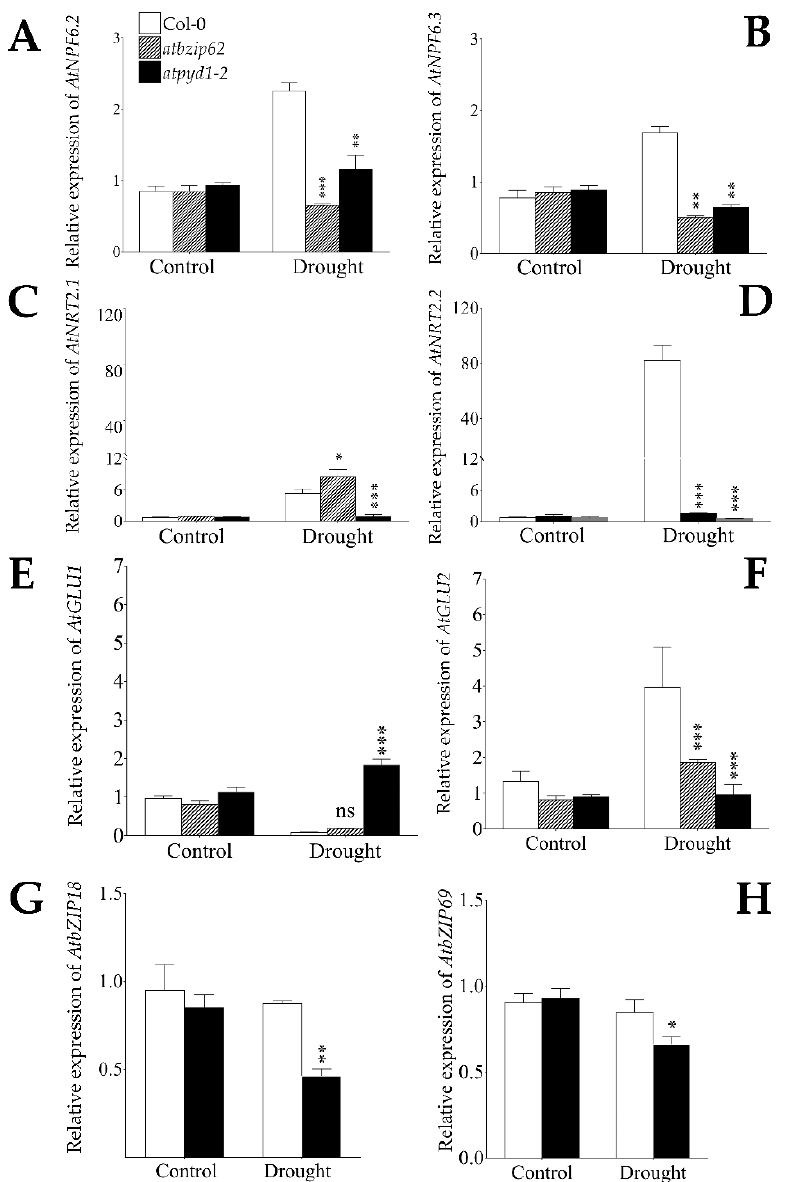
Figure 3. Transcript accumulation of low-, dual-, and high-affinity nitrate transporters and glutamate synthase-encoding genes in response to drought stress monitored in Arabidopsis Col-0, atbzip62 and atpyd1-2 mutant lines lacking AtbZIP62 and AtPYD1 , respectively, under drought stress. ( A ) Expression levels of AtNFP6.2 , ( B ) AtNPF6.3 , ( C ) AtNRT2.1 , ( D ) AtNRT2.2 , ( E ) AtGLU1 , ( F ) AtGLU2 , ( G ) AtbZIP18 , and ( H ) AtbZIP69 upon drought stress induction. Bars are mean values of triplicate ± SD from non-stressed and drought-stressed plants. White bars are Col-0 WT, bars with hatch lines represent the atbzip62 , and black bars indicate the atpyd1-2. The relative expression values of each target gene were normalized to that of the housekeeping gene Actin2 . For statistical significance, the normalized transcript accumulation level of target genes in the mutant lines was compared with that recorded in Col-0 wild type. The statistical significance is indicated on the top of each bar. * p < 0.05, ** p < 0.01, *** p < 0.001, ns non-significant. In addition, AtNPF6.2/NRT1.4 transcript accumulation decreased significantly